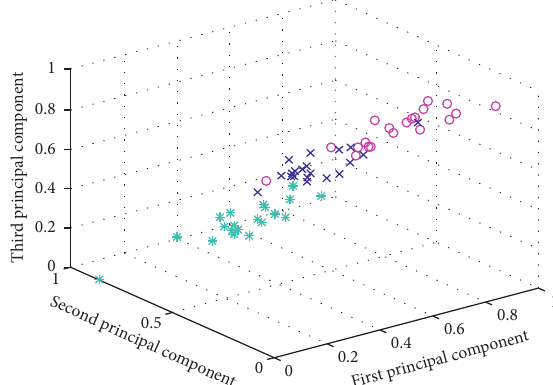
Figure 12: Recognition rate (83.33%) of test data.